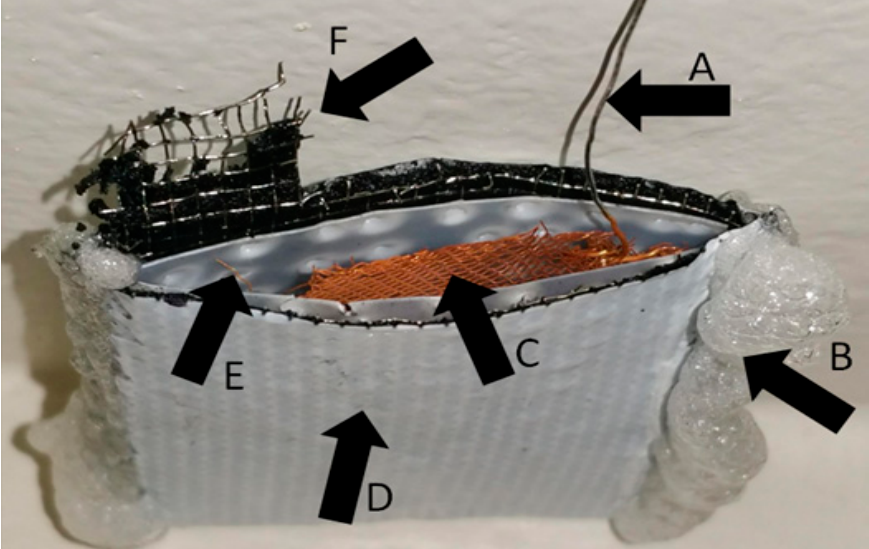
Figure 1. This is the V-shape cell type used in these experiments. (A) Platinum wire used to connect the anode to avoid corrosion contributing to the power output. (B) Adhesive used to prevent leaking. (C) Gold-plated platinum mesh used as the anodic surface. (D) Air-breathing cathode material. (E) Plastic with holes used to prevent electrode contact. (F) Current collecting framework of the air-breathing cathode